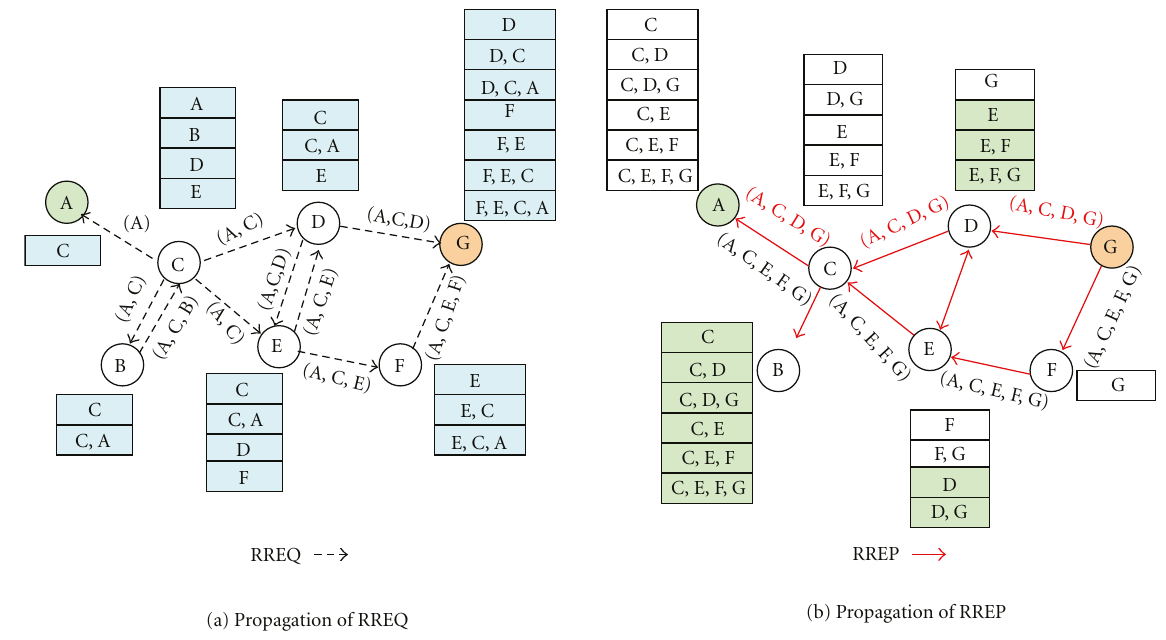
Figure 2: Route discovery and path collection in COSR.